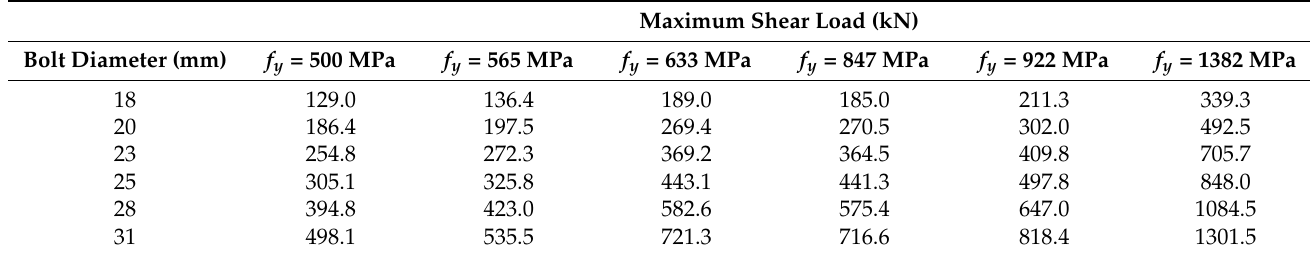
Table 14. Maximum shear load of statically loaded bolts.